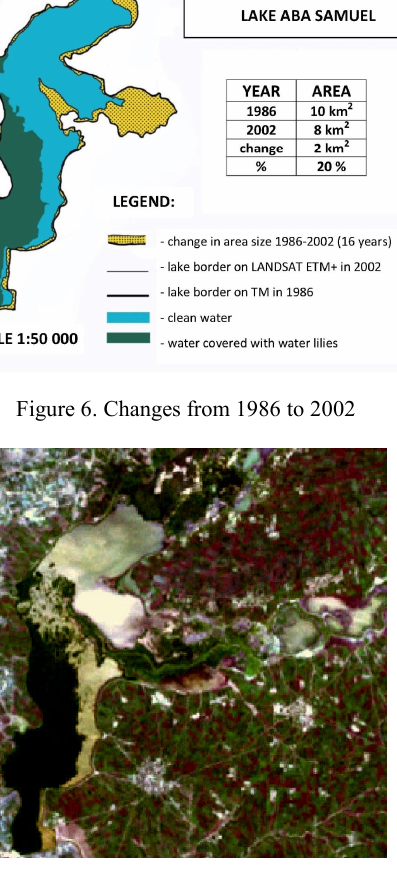
Figure 7. Lake Aba Samuel in